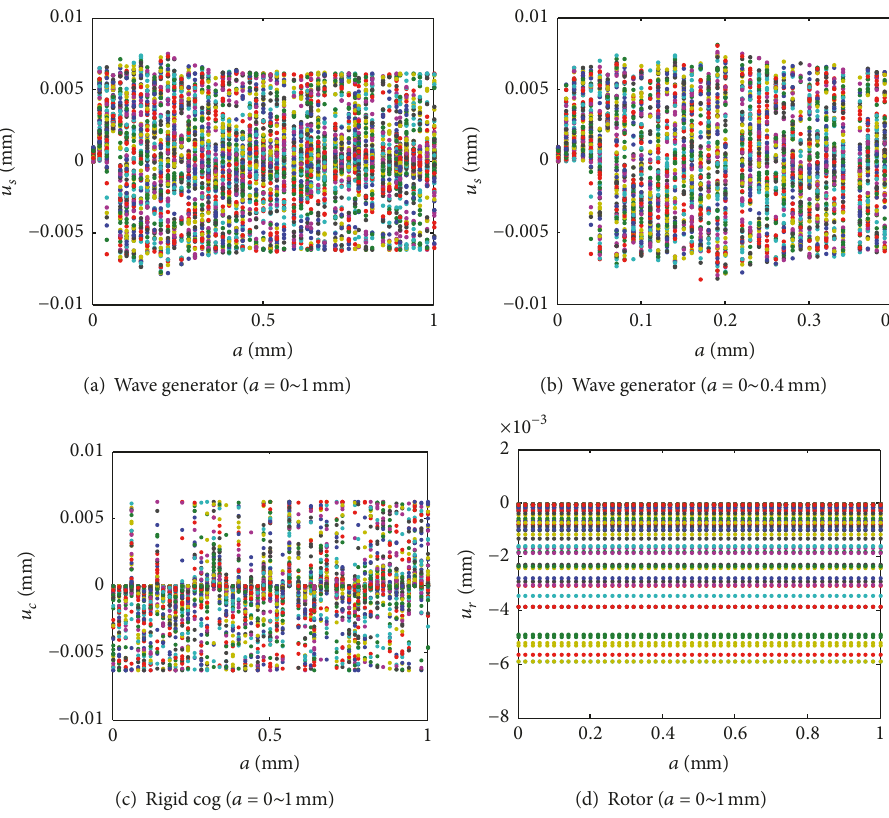
Figure 15: Bifurcation with wave generator